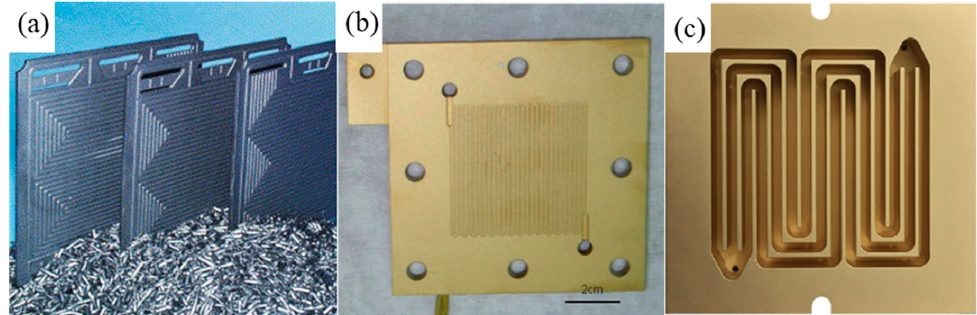
Figure 2. The photos of bipolar plate with ( a ) polymer coating [47], ( b ) TiN coating [48] and ( c ) gold coating [49].